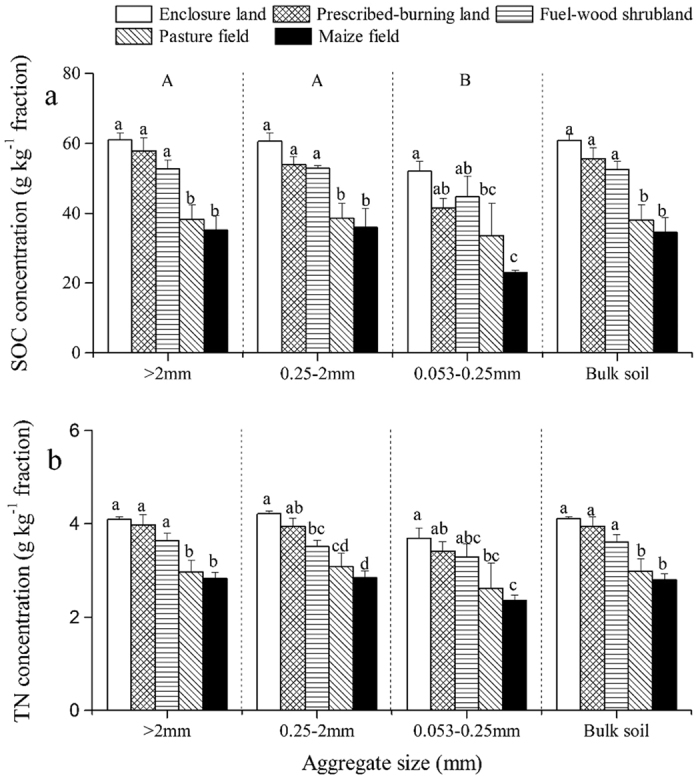
Soil organic carbon (SOC) (a) and total nitrogen (TN) (b) concentrations in the three sizes of soil aggregates and in bulk soil of different land uses. Values are means of three replicates (± standard error). Different lowercase letters indicate significant differences among land uses for each size of soil aggregate and for bulk soil. Different uppercase letters indicate significant differences among the three sizes of soil aggregates.